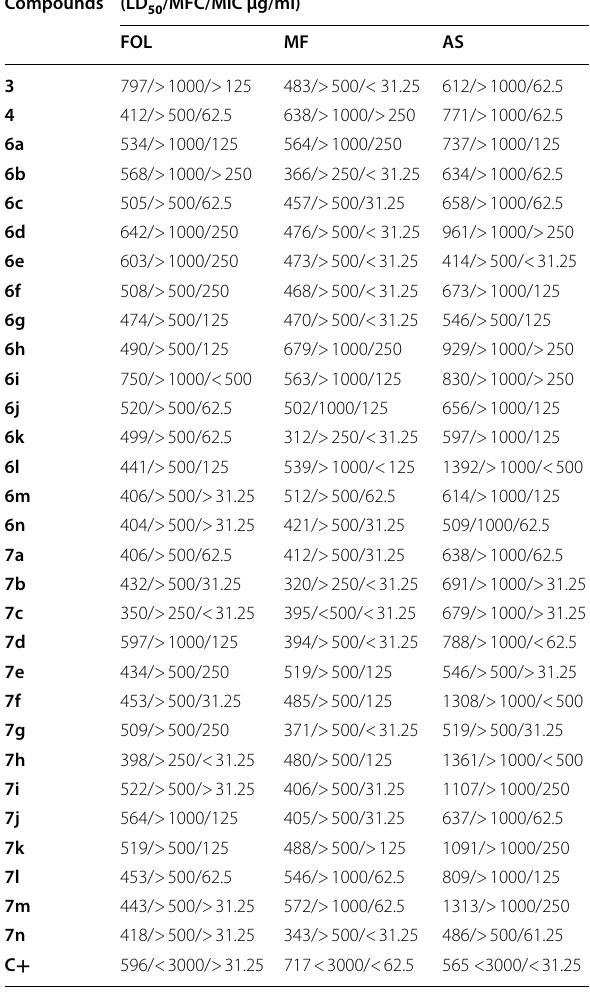
LD 50 , the amount of a substance, which causes the death of 50% (one half) of test fungi; MFC, minimum fungicidal concentration; MIC, minimum